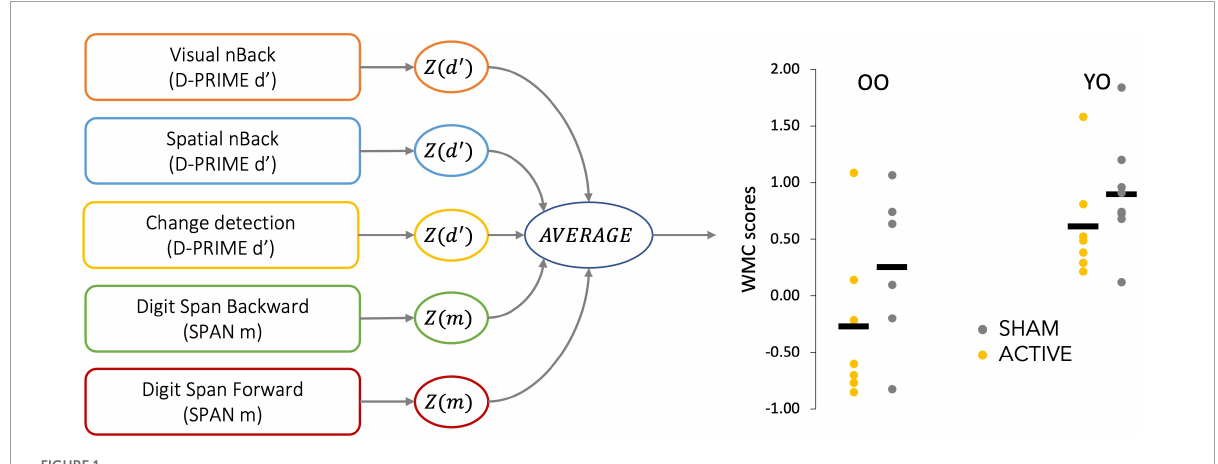
FIGURE1 Diagram of the procedure to calculate composite working memory capacity (WMC) scores. Dependent variables measuring working memory performance were extracted from each task, standardized, and averaged, obtaining a composite score for each participant. The obtained distribution of composite scores is shown for each age and stimulation